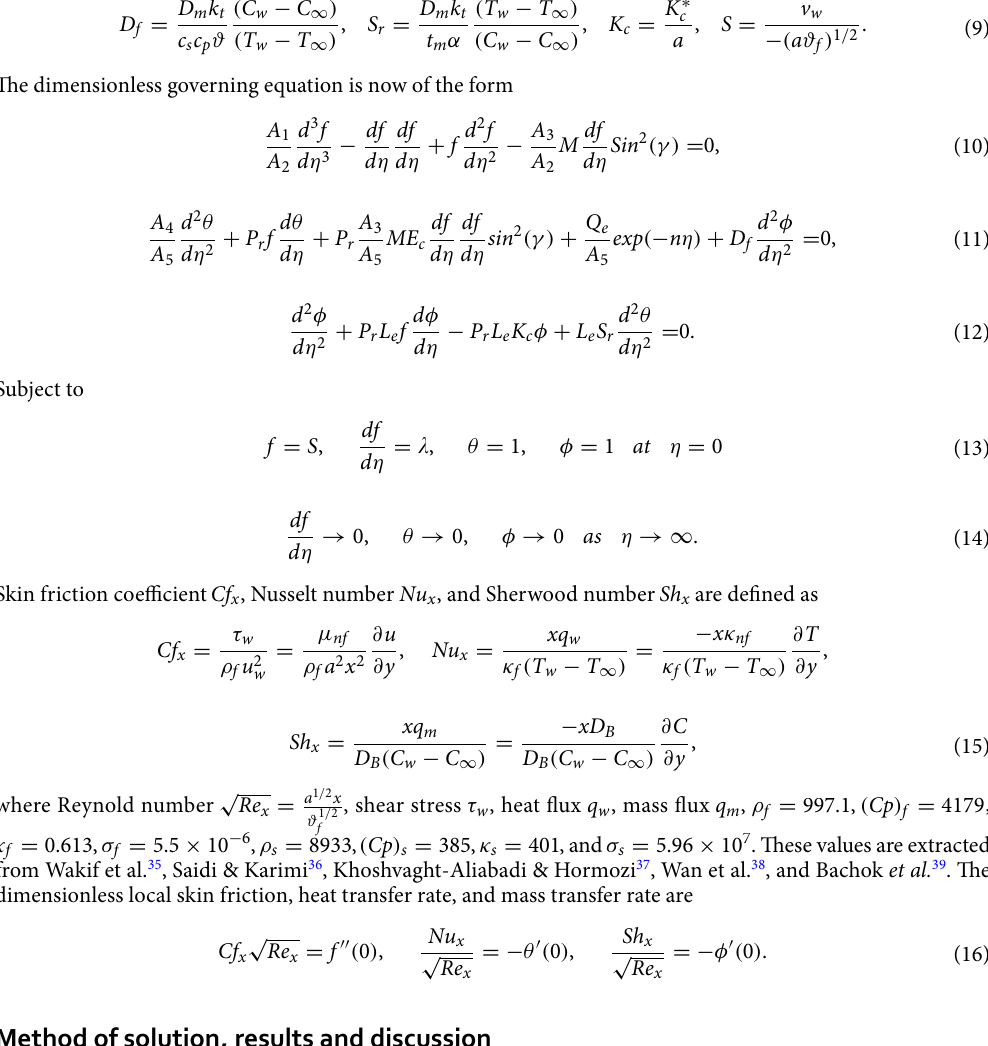
θ ′ ( 0 ) for different values of P r when A 1 −